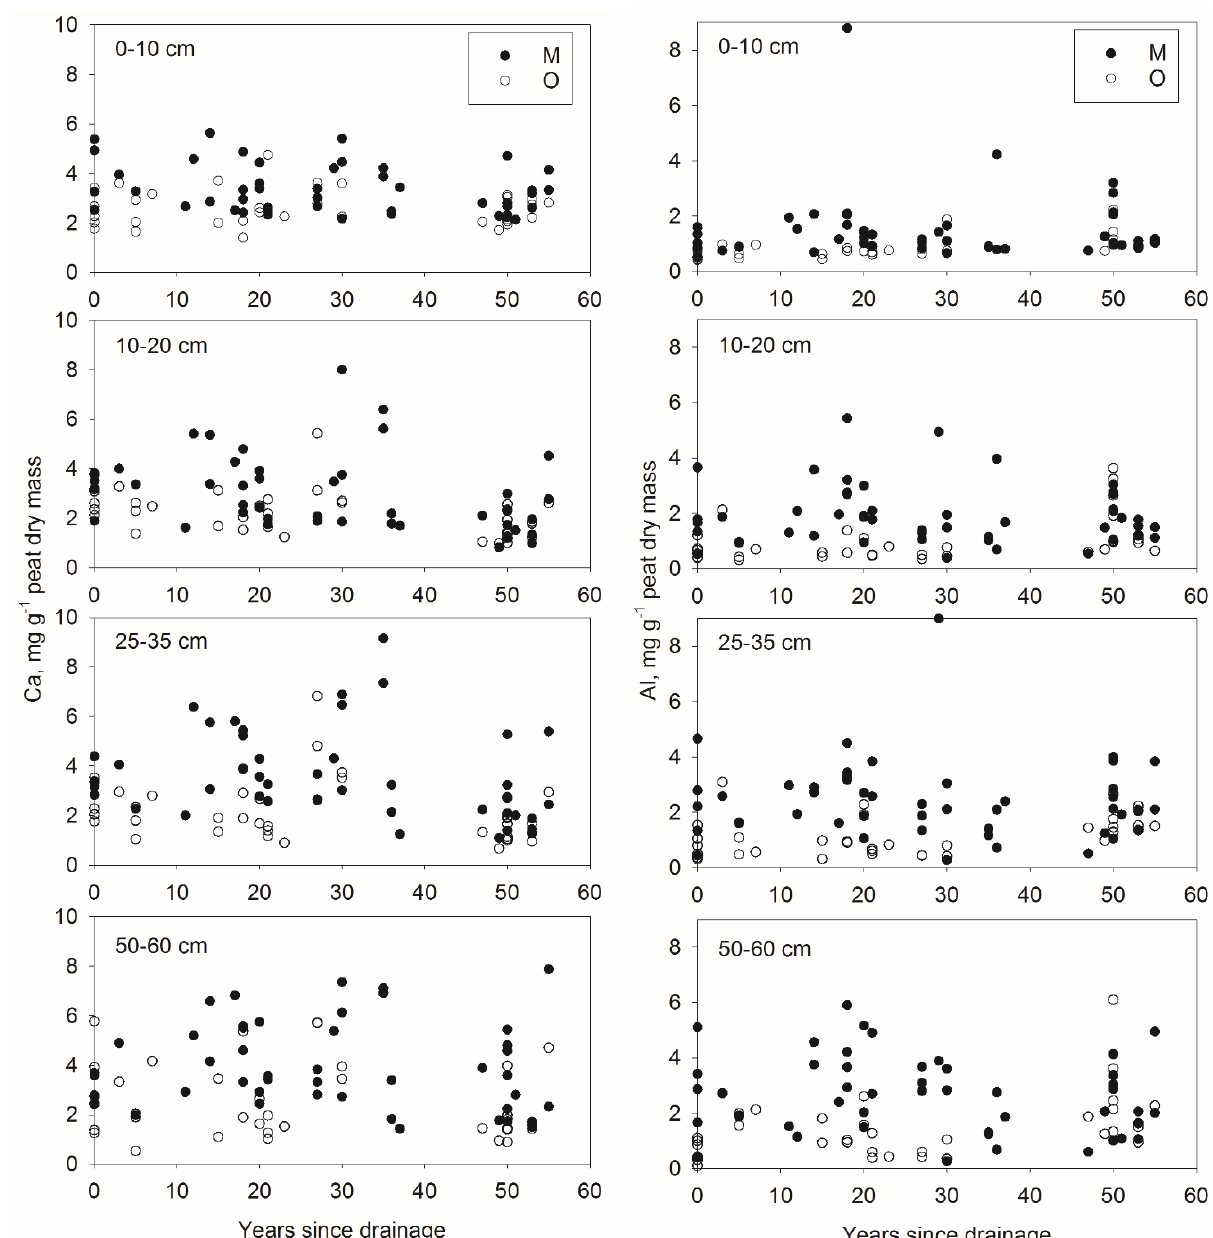
Figure 4. Variation in the concentrations of two example single elements, calcium (Ca, mg g -1 peat dry mass) and aluminium (Al, mg g -1 peat dry mass), at different depths in two site type groups. Sites as in Figure 1. Data from Laiho & Laine (1995). In the Ca panels, the values from one undrained M site which ranged from 11.7 to 17.1 have been